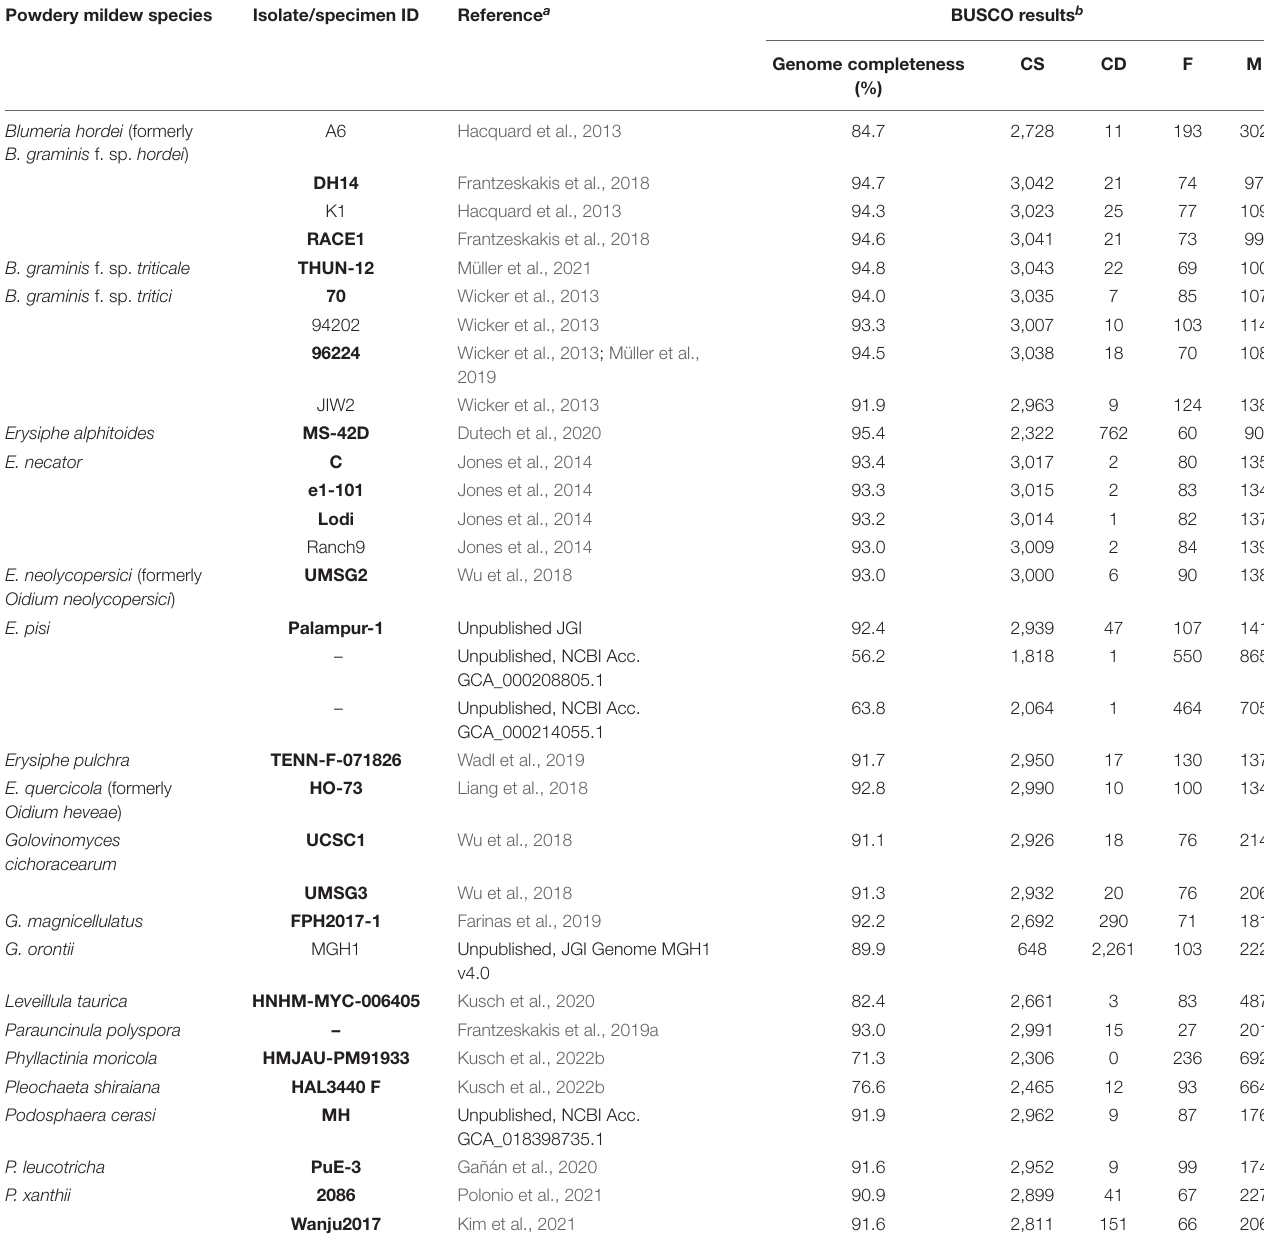
TABLE 2 | List of powdery mildew genomes assessed for completeness through identification of Benchmarking Universal Single-Copy Orthologs (BUSCO) using BUSCO v.5.2.2 (Simão et al., 2015) and Leotiomycetes dataset Odb10. Powdery mildew species